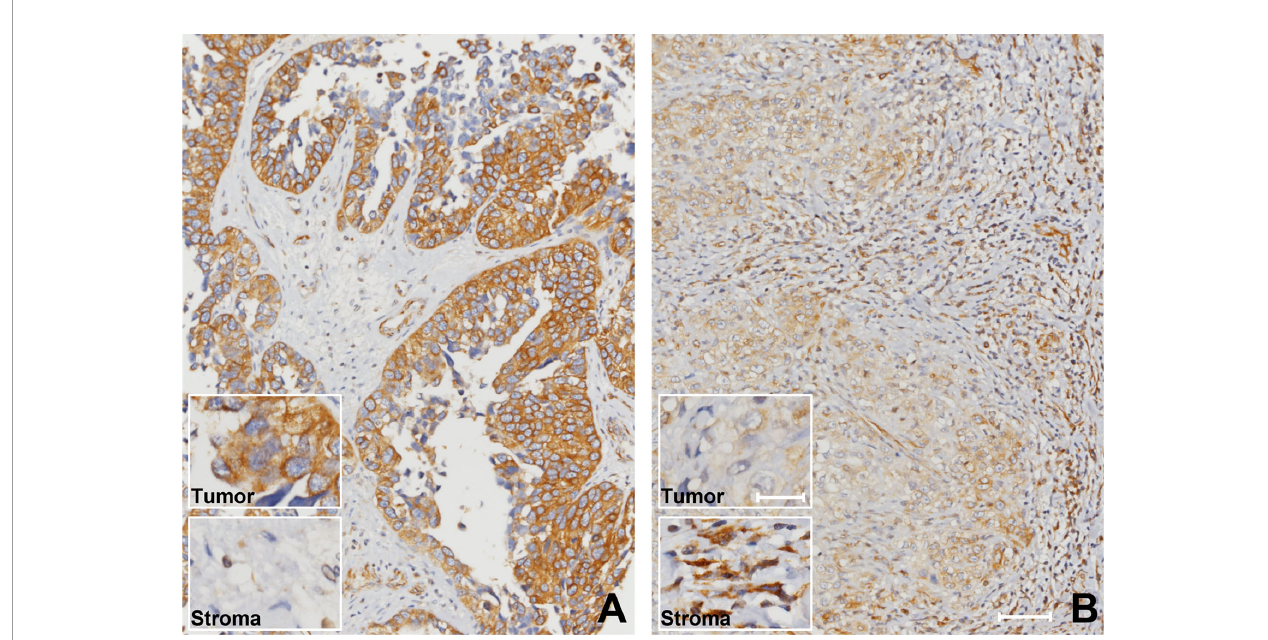
FIGURE 3 | High stromal SFRP2 immunoexpression was observed among bladder cancer patients with advanced stage disease. Immunohistochemistry was performed with an anti-SFRP2 antibody. SFRP2 immunoreactivity in stroma was gradually increased from (A) non-muscle-invasive to (B) muscle-invasive bladder